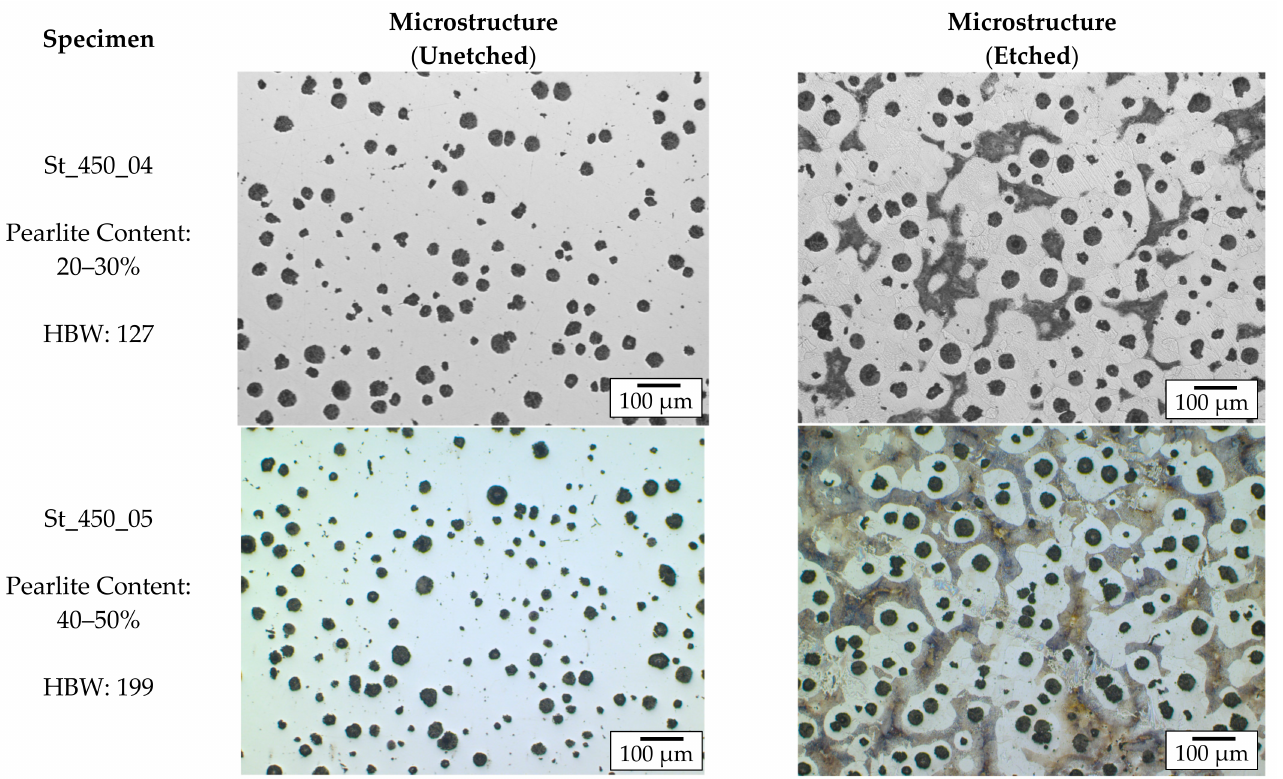
Figure 9. Comparison of the microstructures and Brinell hardnesses of specimens St_450_05 and St_450_04 tested under static tensile